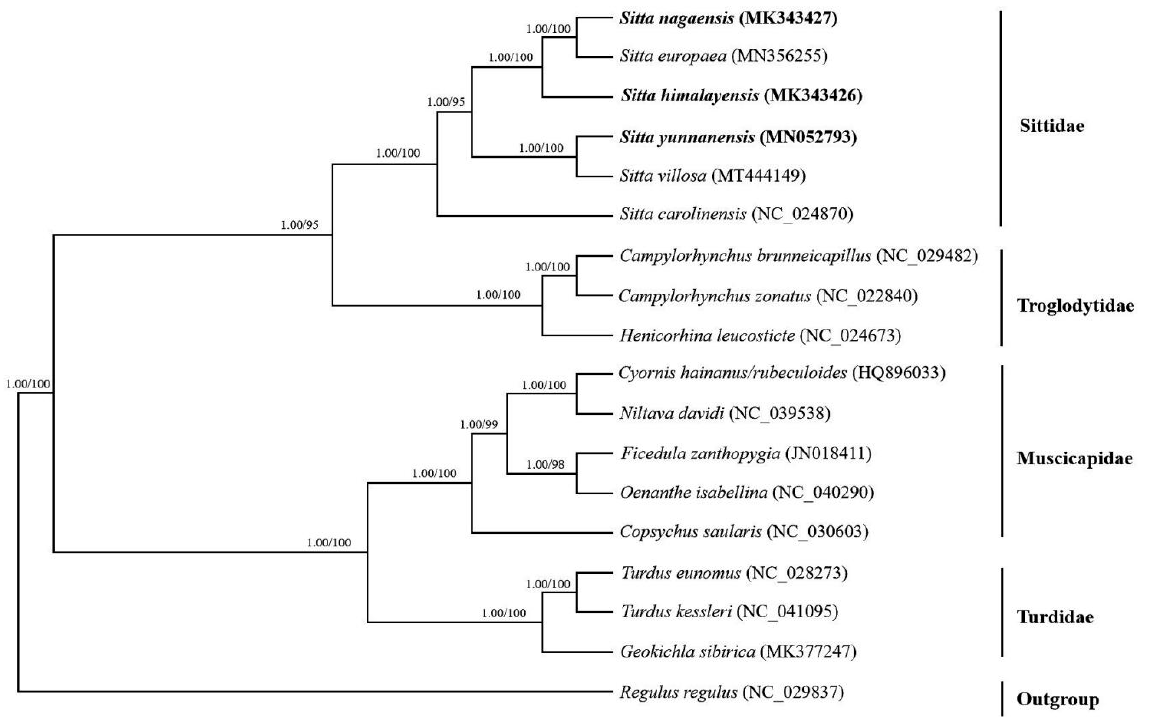
Figure 5. Phylogeny from Sitta mitochondrial genome sequences. Bayesian inference (BI) and maximum likelihood (ML) analyses inferred from protein-coding genes supported the same topological structure. Values at nodes are Bayesian posterior probabilities and ML bootstrap values. The tree is rooted with one outgroup ( Regulus regulus ).